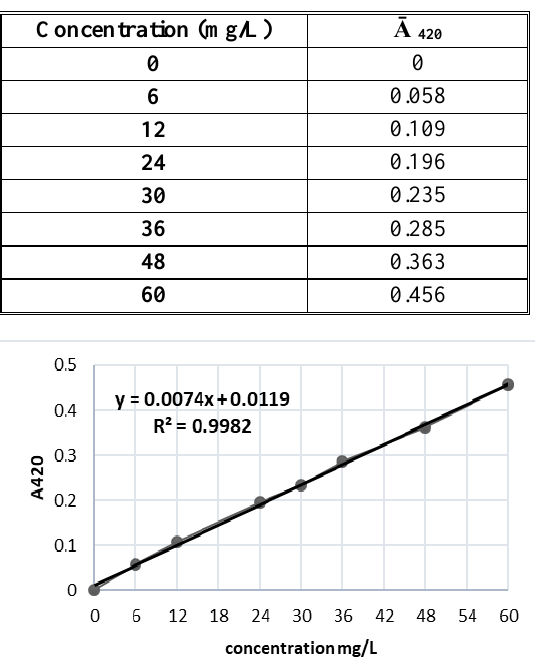
Table 5. Quercetin concentrations and their absorbances